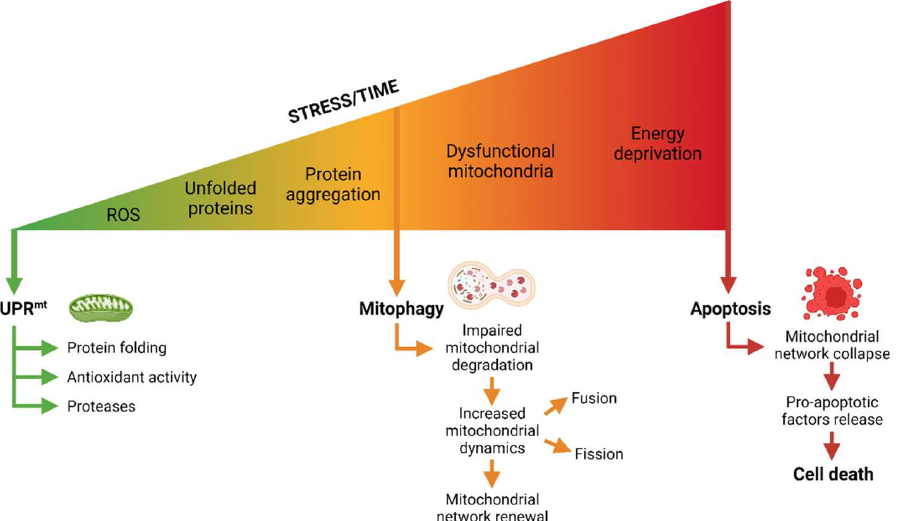
Figure 1. Mitochondrial stress response. The most common mitochondrial stressors are ROS, unfolded proteins, and protein aggregates. To deal with such insults and their consequences, mitochondria possess several mechanisms: First, the UPR mt will promote the expression of antioxidant proteins, chaperones, or proteases. If damage persists and/or increases, the cell will try to remove highly damaged mitochondria with mitophagic processes. Mitophagy degrade dysfunctional mitochondria by a combination of mitochondrial fission and autophagy; then mitochondrial biogenesis and fusion are enhanced to restore energetic balance. All of these quality- control mechanisms are non-exclusives, and cells can regulate them according to the situation. Finally, if the cell is unable to overcome the energetic crisis, it will undergo apoptosis through mitochondrial release of pro-apoptotic factors. Figure was created with BioRender (BioRender.com).